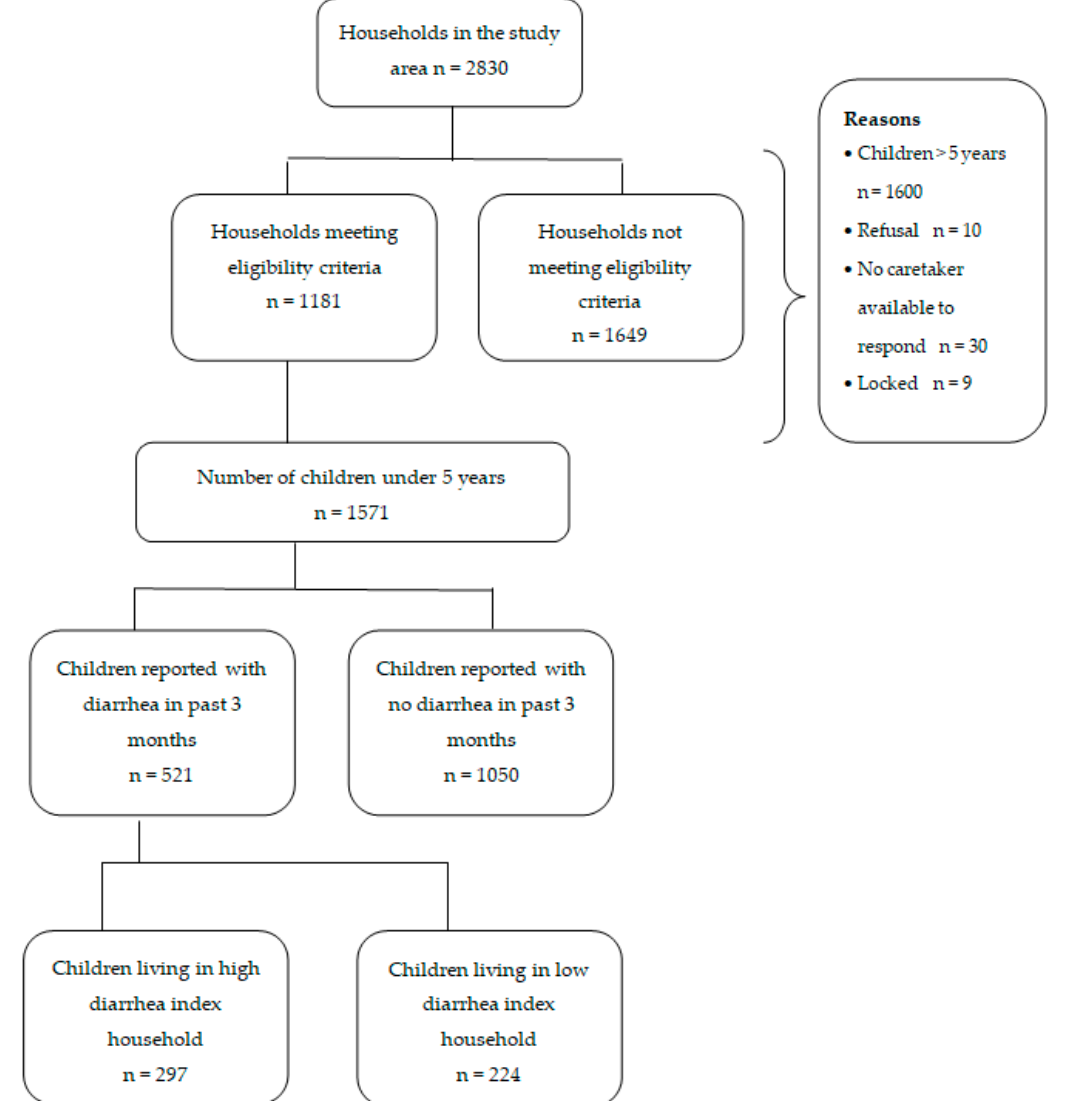
Figure 1. Process of selection of the study participants and their distribution according to low and high diarrheal index households in the study.